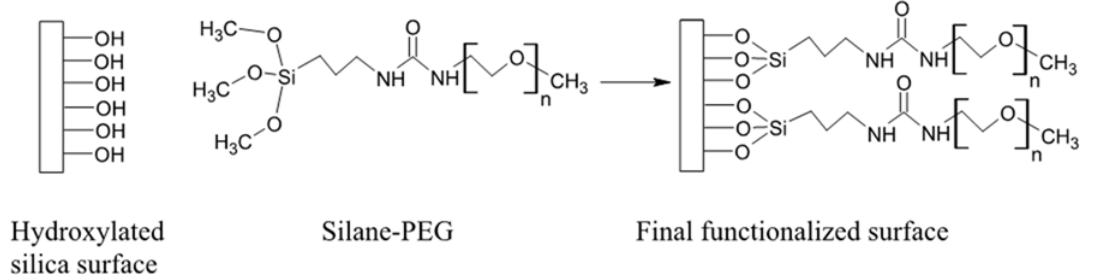
Figure 4. Functionalization process of silica microsphere’s surface via a two-step covalent process. Adapted with permission from [35]. Copyright (2012) American Chemical